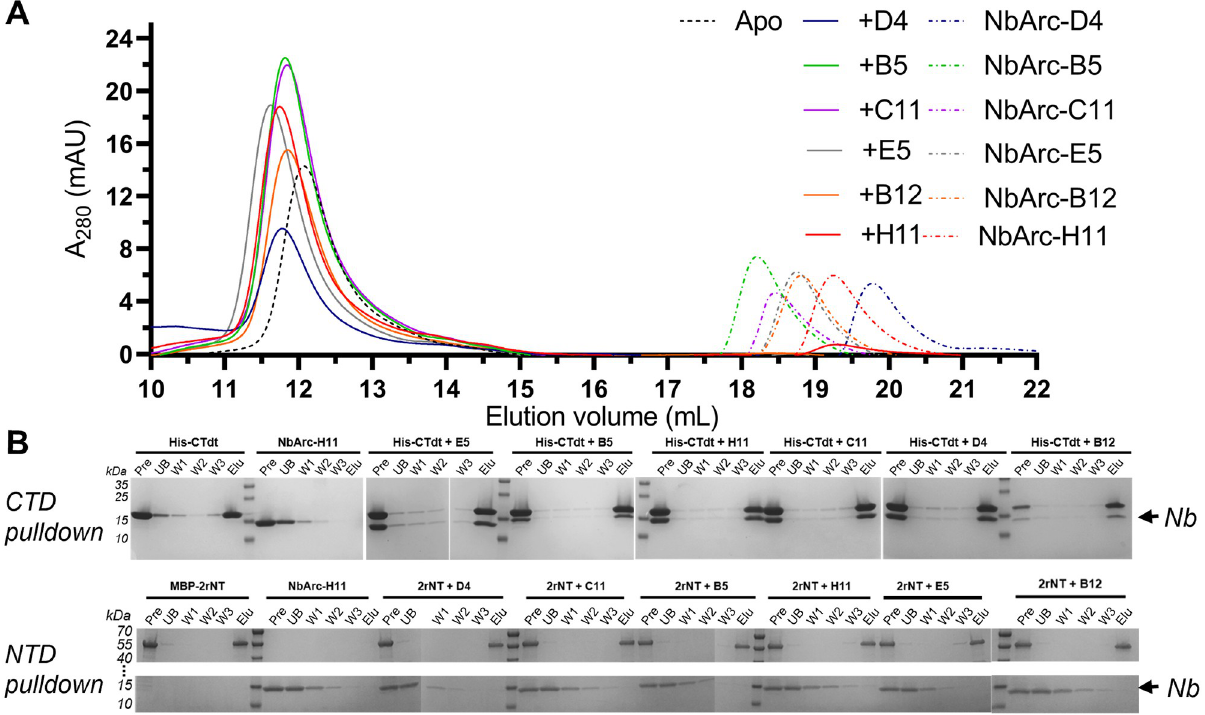
Fig 3. Initial characterisation of Nb binding to Arc. A Analytical SEC demonstrated Nb binding to FLrArc-7A. B NiNTA Nb pulldown assay with equimolar amounts of His-tagged hArc-CTD (CTD) or MBP-2rNT (NTD) and untagged Nbs, followed by SDS-PAGE analysis. All Nbs associated with the CTD (upper panel), as noted by the presence of the Nb band in all complex elutions, whereas none bound to the NTD (lower panel). Pre denotes the complex prior to loading on the matrix, UB the unbound fraction, W1-3 the three washing steps, and Elu the eluted fraction. All unmodified SDS-PAGE gel images of the current study are in S14 Fig.